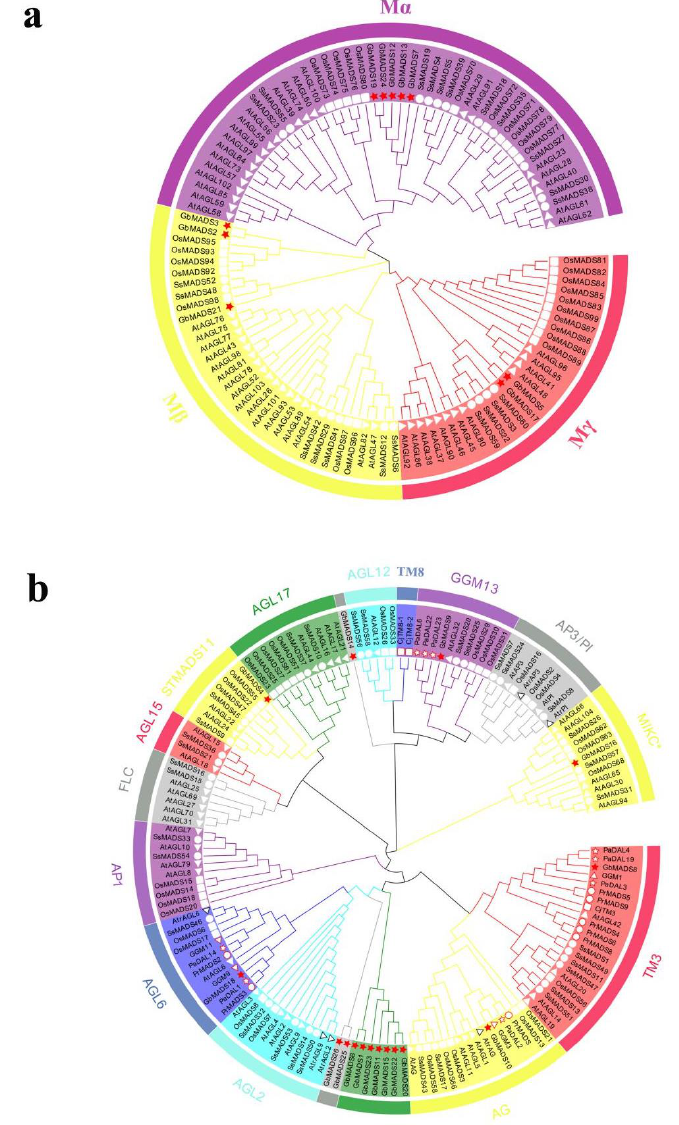
Figure 4. ( a ) Evolutionary tree of type-I MADS-box gene family; ( b ) Evolutionary tree of type-II MADS-box gene family. The phylogenetic tree was generated with 1,000 bootstrap replicates using the neighbor-joining (NJ) method. Each subgroup ’s name was in the outer circle of the phylogenetic tree, and different subgroups were marked with different colors. Genes of different species were marked in the inner circle with different shapes and colors, Gb, Ginkgo biloba (star, red, red border); At, Arabidopsis thaliana (triangle, white, white border); Os, Oryza sativa (square, white, white border); Ss, Salix suchowensis (circular, white, white border); GGM, Gnetum gnemon (triangle, white, red border); Cj, Cryptomeria japonica (square, white, red border); Pa, Picea abies (star, white, red border); Atr, Amborella trichopoda (triangle, white, black border); Pr, pinus radiata (circular, white, red